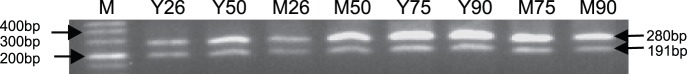
RT-PCR analysis of NNAT mRNA in different placentas of different breeds and at different developmental stages.The 280 base pair NNAT-α sequence and the 199 base pair NNAT-β sequence were both detected in all samples. From left to right, the lane contents were as follows: 500 base pair DNA ladder (Takara), products amplified from the placentas of Yorkshire pigs on day26 and d50 of gestation, Meishan pigs on day26 and day50 of gestation, Yorkshire pigs on day75 and d90 of gestation, and Meishan pigs on day75 and d90 of gestation.